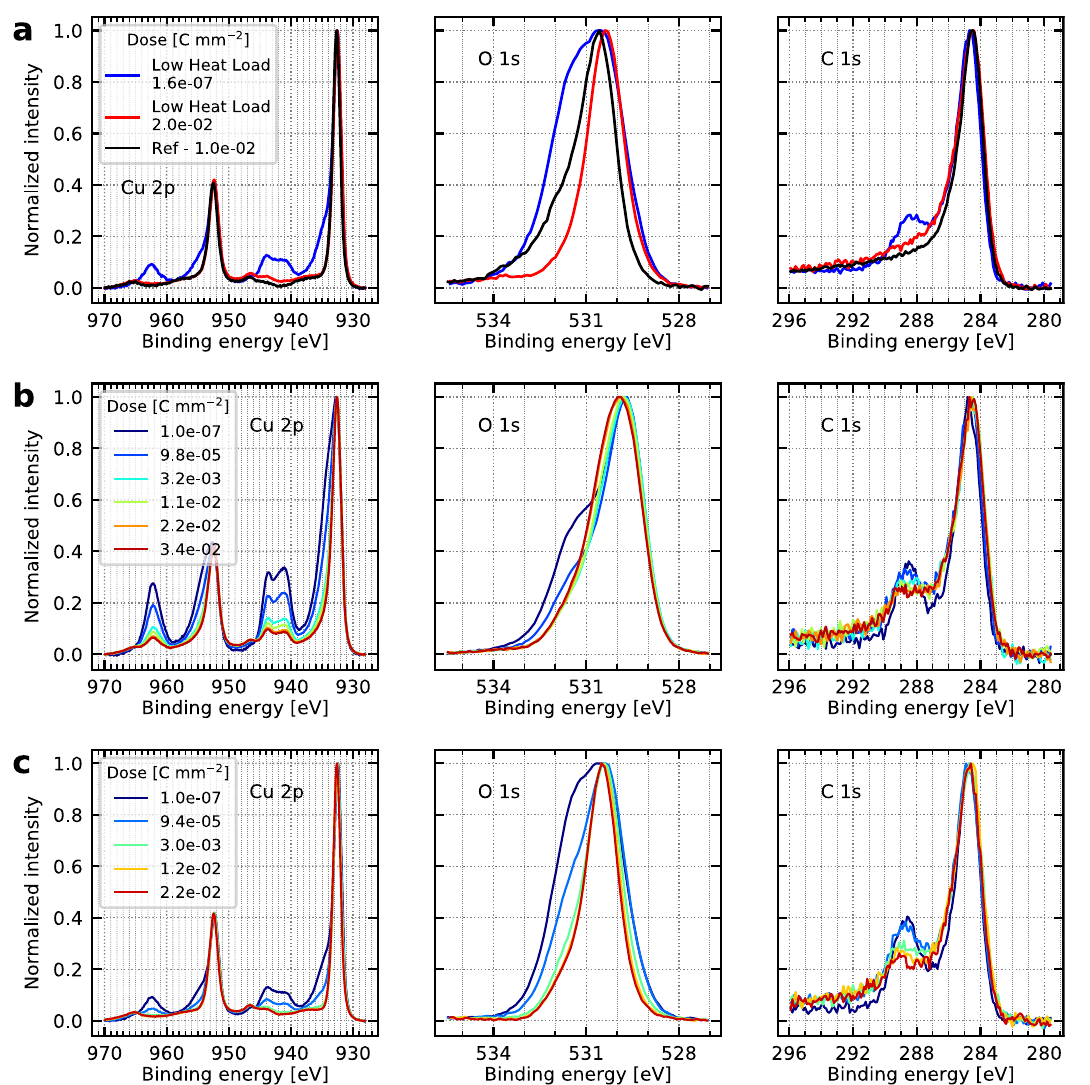
Fig. 8 Surface chemistry during conditioning. Cu 2p, O 1s, and C 1s X-ray photoelectron spectroscopy (XPS) core level spectra at a different dose (represented by the corresponding colours) during conditioning of a the Low Heat Load sample and the reference sample, b the High Heat Load bottom sample, and c the High Heat Load lateral side